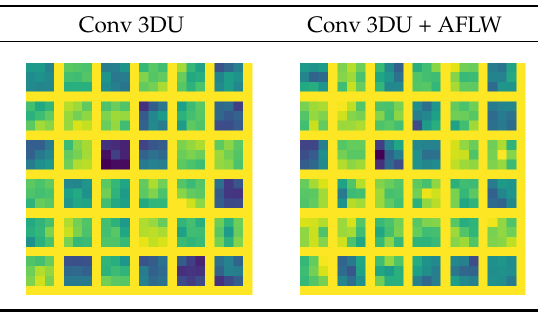
Figure 8. Results obtained for both pipelines of face landmark detection with different combinations of datasets. Table 3. Representation of the last layer of convolution from VainillaCNN.